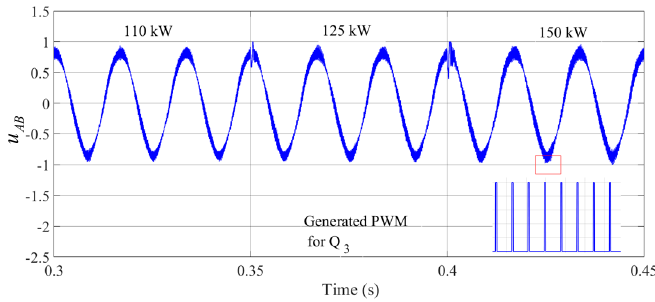
Figure 19. Control signal u AB and a portion of the generated Figure 19. Control signal 𝑢 (cid:3002)(cid:3003) and a portion of the generated PWM. Figure 19. Control signal 𝑢 (cid:3002)(cid:3003) and a portion of the generated PWM.